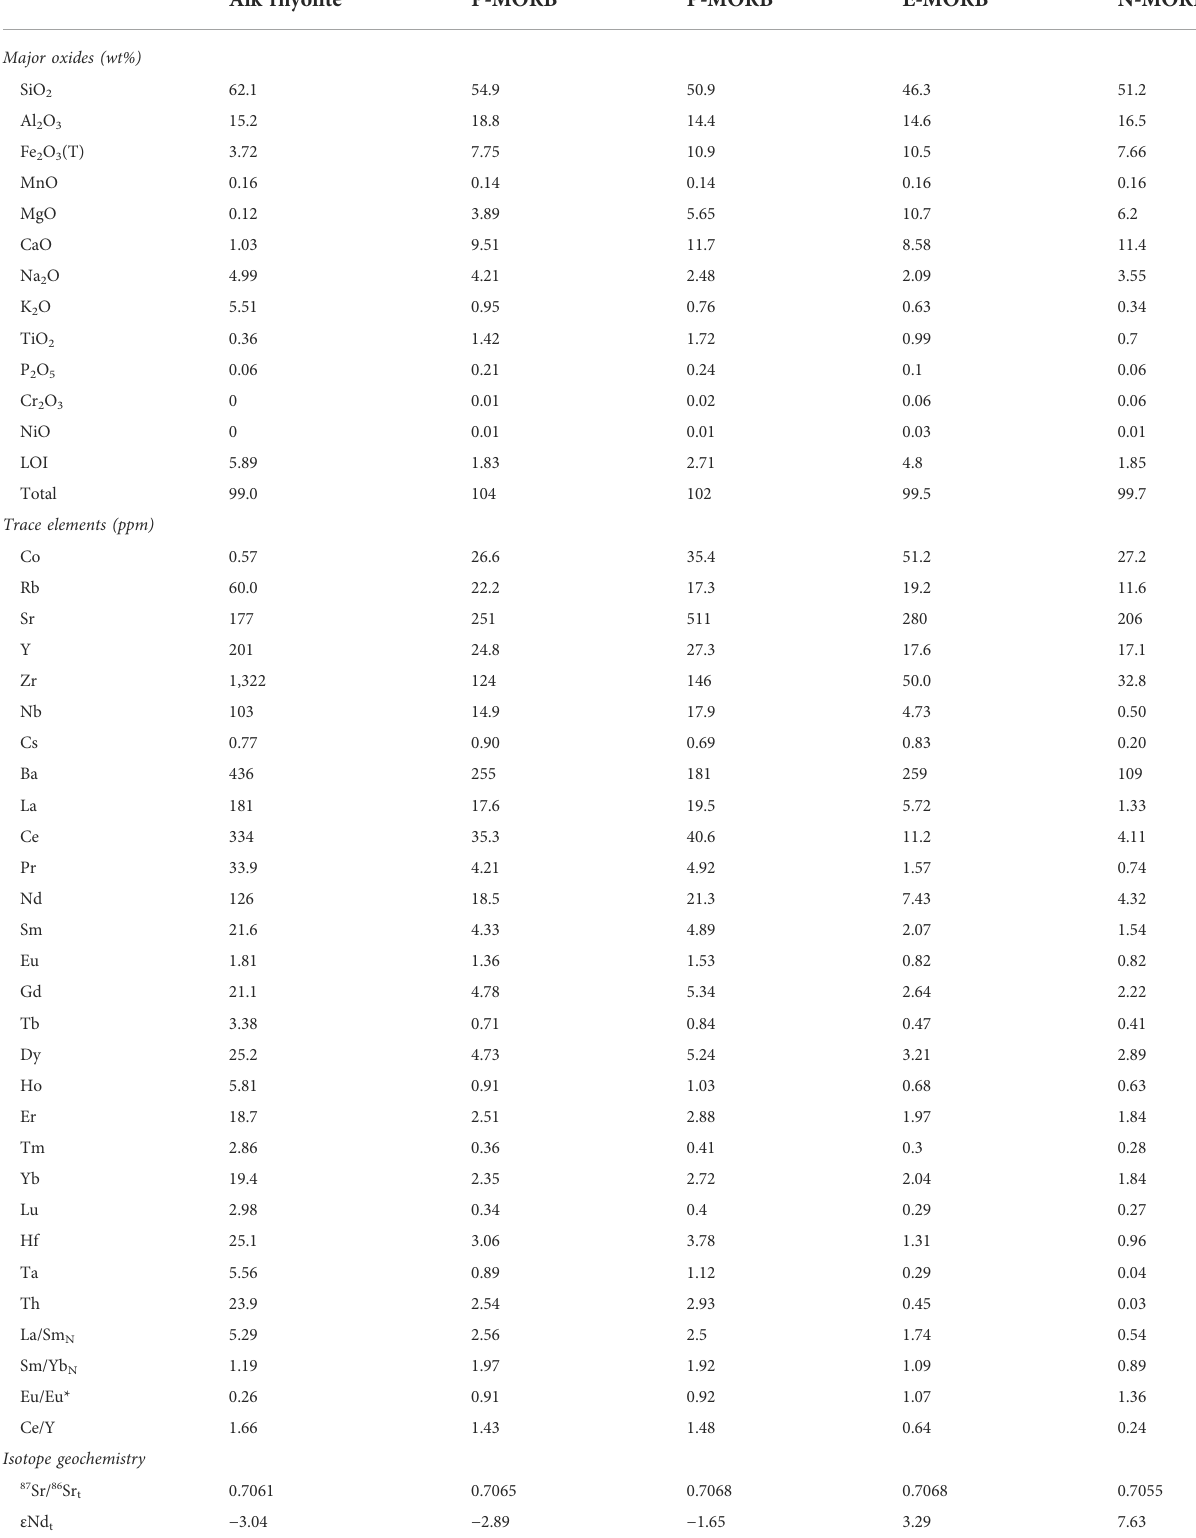
TABLE 1 Bulk rock geochemical analysis of the Zarao Metavolcanic Rocks. Alk rhyolite P-MORB P-MORB E-MORB